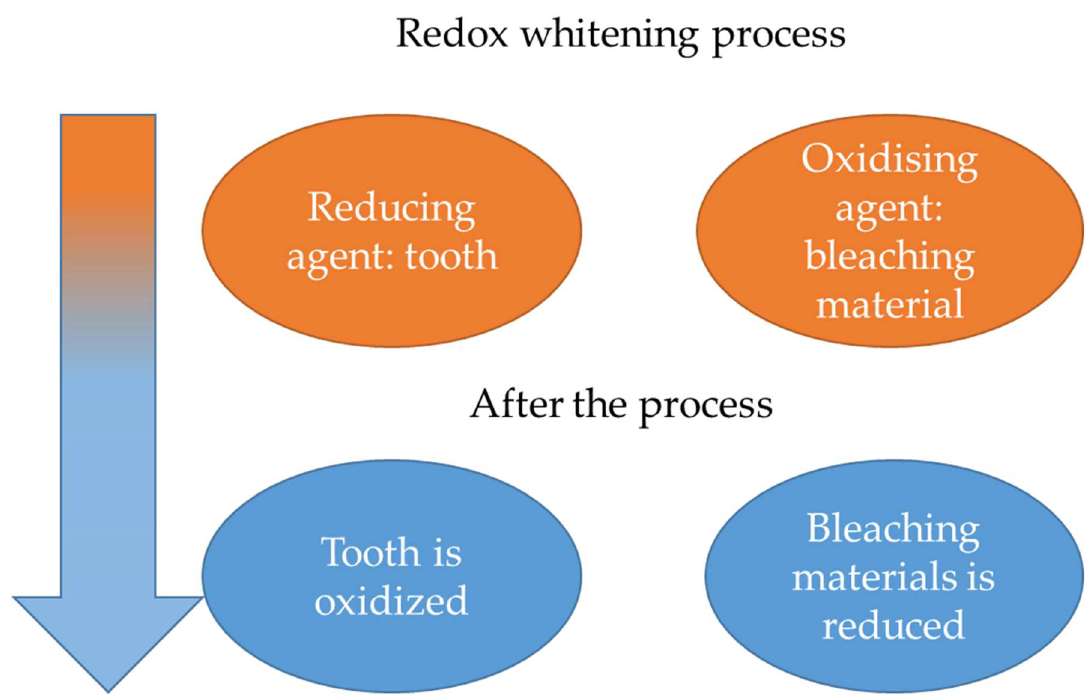
Figure 1. Redox whitening process.